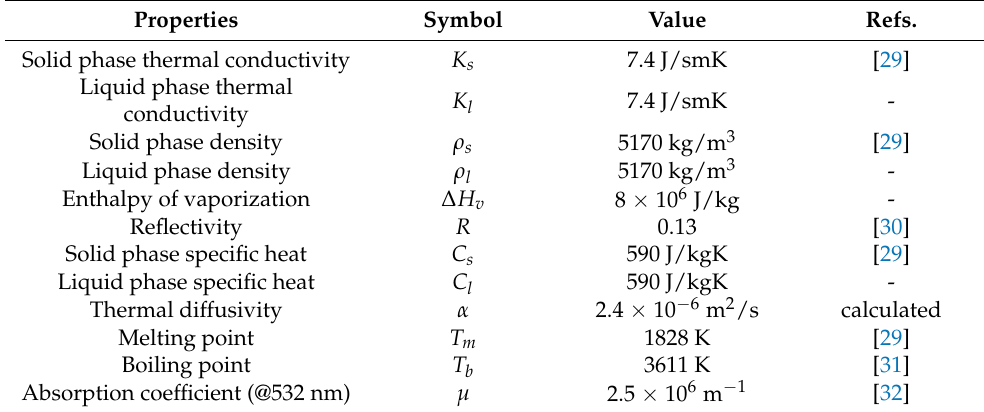
Table 2. Thermal and optical properties of Yttrium-Iron Garnet (YIG) used for